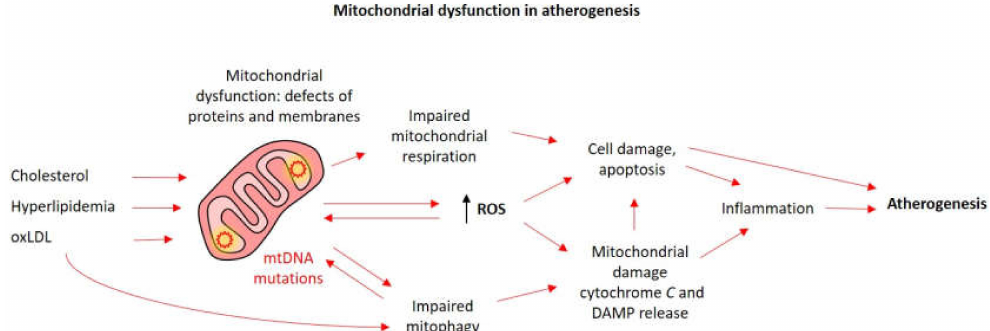
Figure 1. Mitochondrial dysfunction in atherosclerosis. External damaging stimuli (arrows), such as excessive lipids and oxLDL and internal accumulation of mtDNA mutations lead to progressive mitochondrial dysfunction. Impaired mitophagy hinders mitochondrial turnover and replenishment of functional organelles. Increased reactive oxygen species (ROS) formation further contributes to mtDNA mutagenesis and mitochondrial damage. These processes eventually lead to mitochondrial damage with the release of damage-associated molecular patterns (DAMP) and apoptosis-triggering molecules, causing cell death and inflammation and contributing to